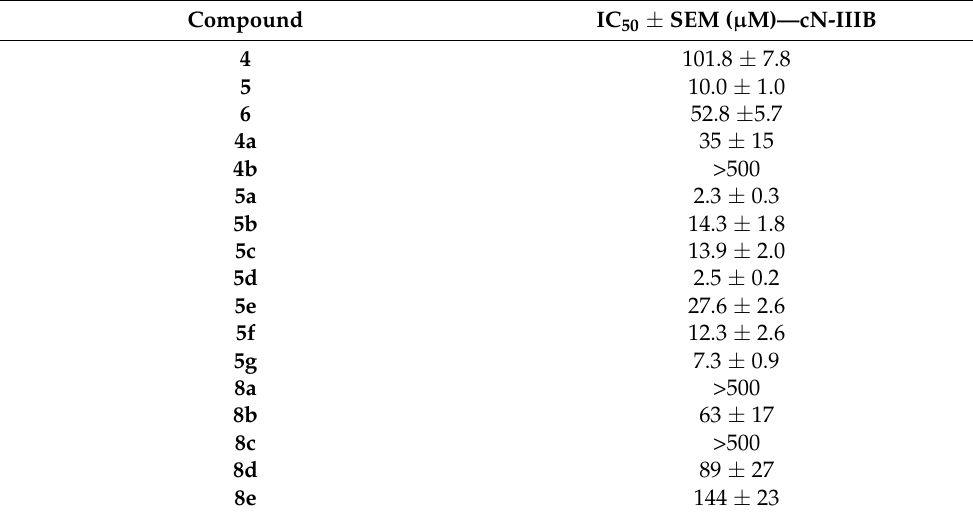
Table 1. The IC 50 values for second-generation inhibitors of cN-IIIB enzyme and parent compounds 4, 5, and 6